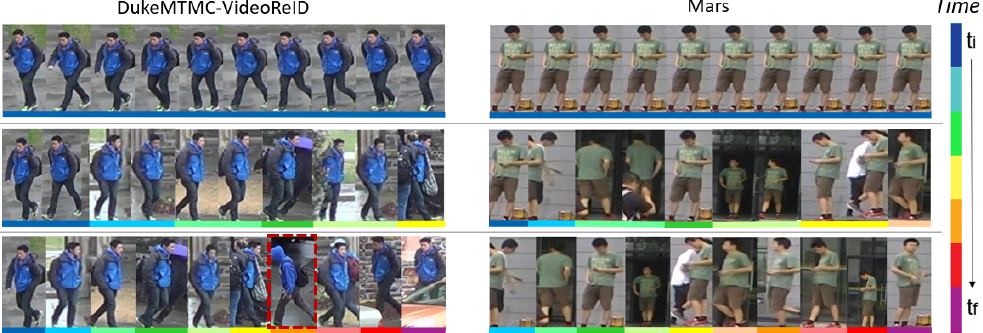
Figure 7. Visualization of the evolution of appearance models in the gallery. Each row corresponds to gallery samples at a certain time. The different colors represent the time stamp of the samples included in the gallery (best viewed in